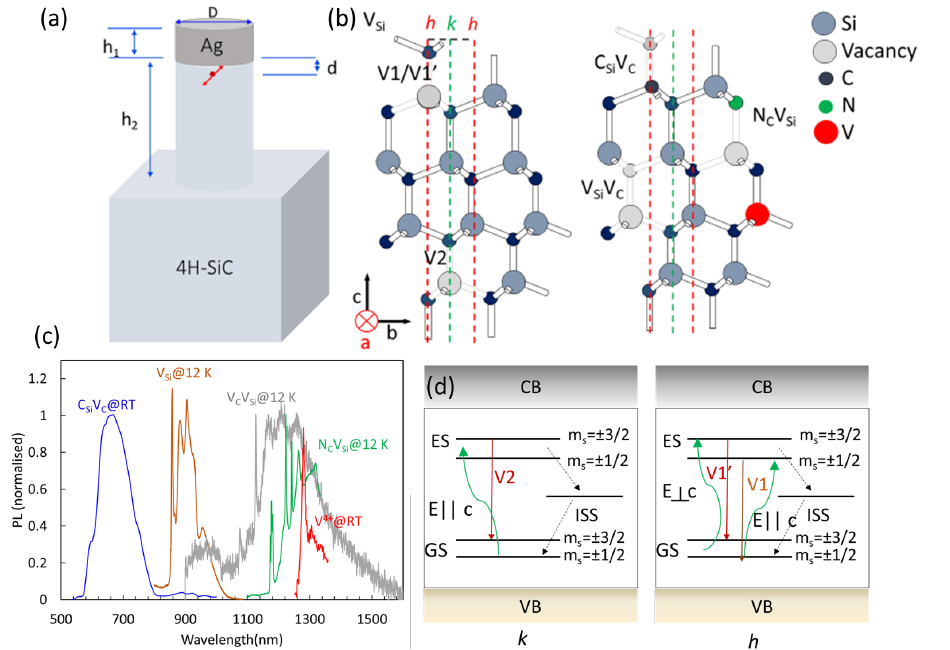
Figure 1. ( a ) Nanopillar antenna-resonator in 4H-SiC and Ag, where optimization of the nanopillar and antenna height (h 1,2 ), nanopillars diameter (D), dipole distance from the antenna (d) are studied. ( b ) Crystallographic representation of 4H-SiC with hexagonal (h) and cubic (k) sites location for Si and C, showing the h and k sites for the V Si and the h site for carbon vacancy pair ( C Si V C ) and N C V Si , and the k site for the divacancy V C V Si and Vanadium (V). The direction of the c-axis is also shown. ( c ) Spectroscopy at room and low temperature of here studied color centres. Single C Si V C at room temperature (RT) measured using a home-built scanning confocal microscope with 532 nm excitation as described in ref. [27] based on samples fabricated as described in ref. [28]. Ensemble of V Si implanted on a c-face grown 4H-SiC, showing the ZPLs of the V1/V1’ lines for the centre at the h site and the V2 line for the centres at the k site. As the substrate is grown on the c-face the dominant emission is the V1’ due to its dipole laying in the plane of the substrate (excited by a laser perpendicular to the c-axis). Additional PL at 12 K of ensemble of V Si V C , N Si V C and RT V + 4 . V Si , V Si V C , and N Si V C are excited using 780 nm and 976 nm respectively and measured using a commercial Horiba Raman system and home built confocal systems operating at low and room temperature equipped with infrared spectrometer and single photon detectors as described in ref. [12,27]. Samples are created as described in ref [12]. V + 4 was not measured but deduced from ref. [29]. ( d ) Schematic of the energy levels (Ground state, GS, excited state, ES, and intersystem state, ISS) of the V1’/V1 and V2 emitters, showing that V1 and V2 are excited with an electric field parallel to the c-axis, while V1’ with an electric field perpendicular to the